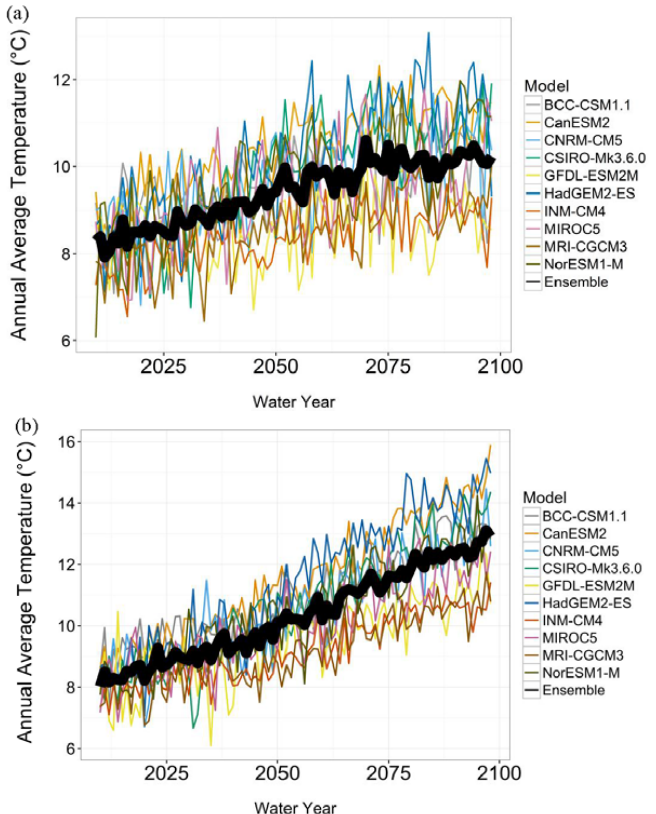
Figure 2. ( a ) Annual mean temperature for all global climate models (GCMs) for Representative Concentration Pathway (RCP) 4.5 with the ensemble mean in black. ( b ) Annual mean temperature Concentration Pathway (RCP) 4.5 with the ensemble mean in black; ( b ) Annual mean temperature for for all GCMs for RCP 8.5. all GCMs for RCP